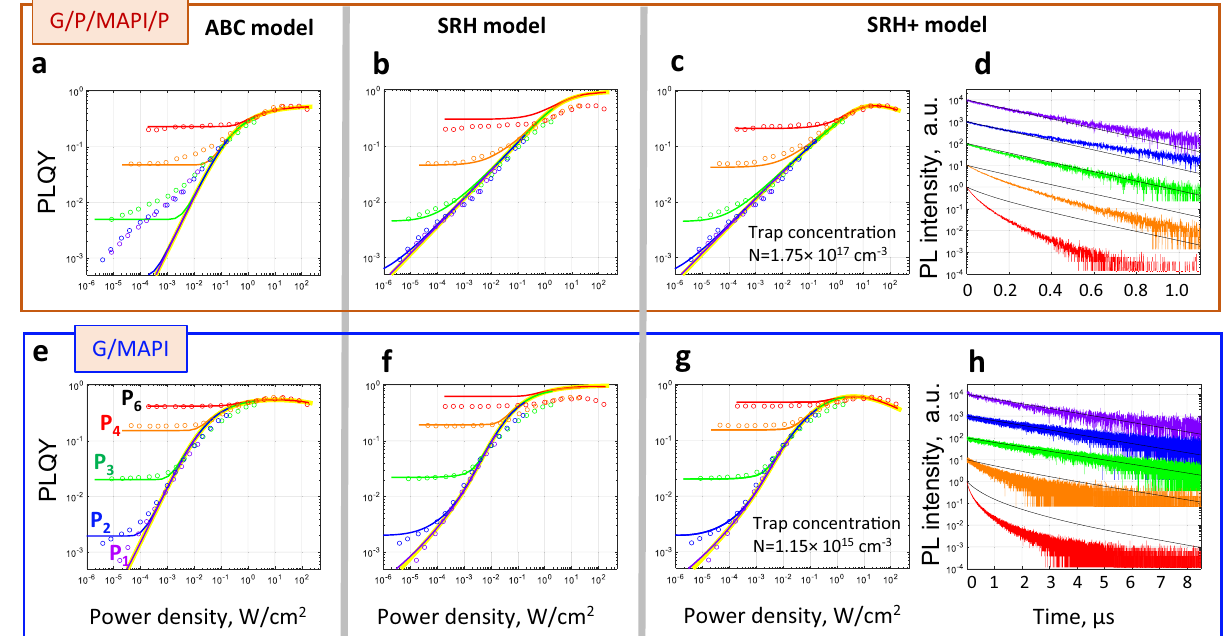
Fig. 5 Fitting of the PLQY( f , P ) maps and PL decays by all models. a ABC, b SRH, c SRH + models applied to the MAPbI 3 fi lm and e ABC, f SRH, g SRH + models applied to the MAPbI 3 fi lm with PMMA interfaces. In PLQY maps the symbols are experimental points, the lines of the same colour are the theoretical curves. d and h show experimental and theoretical (black lines) PL decays according to the SRH + model for both samples, laser repetition rate — 100 kHz. The pulse fl uences are indicated according to the colour scheme shown in e in the whole fi gure. Theoretical CW regime is shown by the yellow lines in all PLQY maps. The model parameters can be found in Supplementary Note